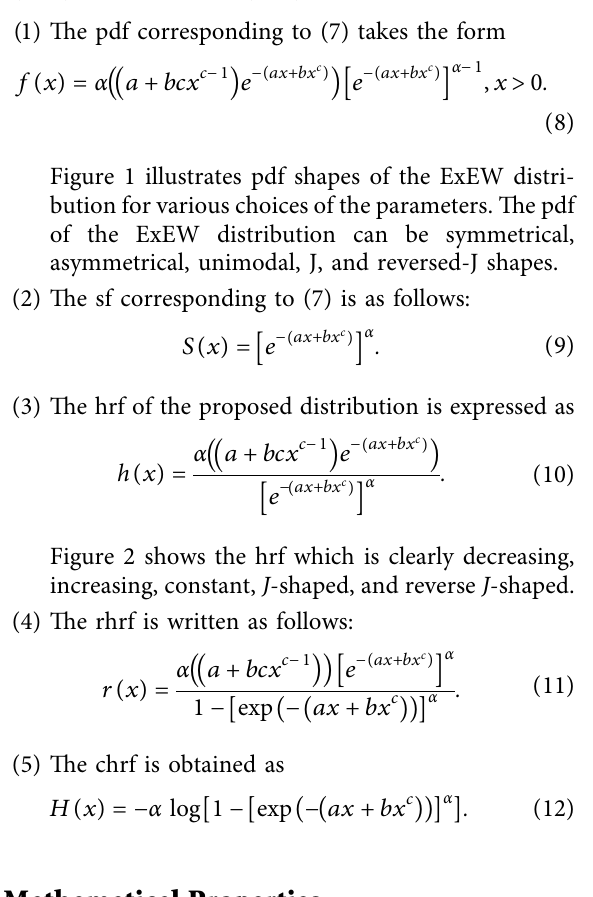
Figure 1: Shapes of the pdf of the ExEW distribution for various choices of the parameters.